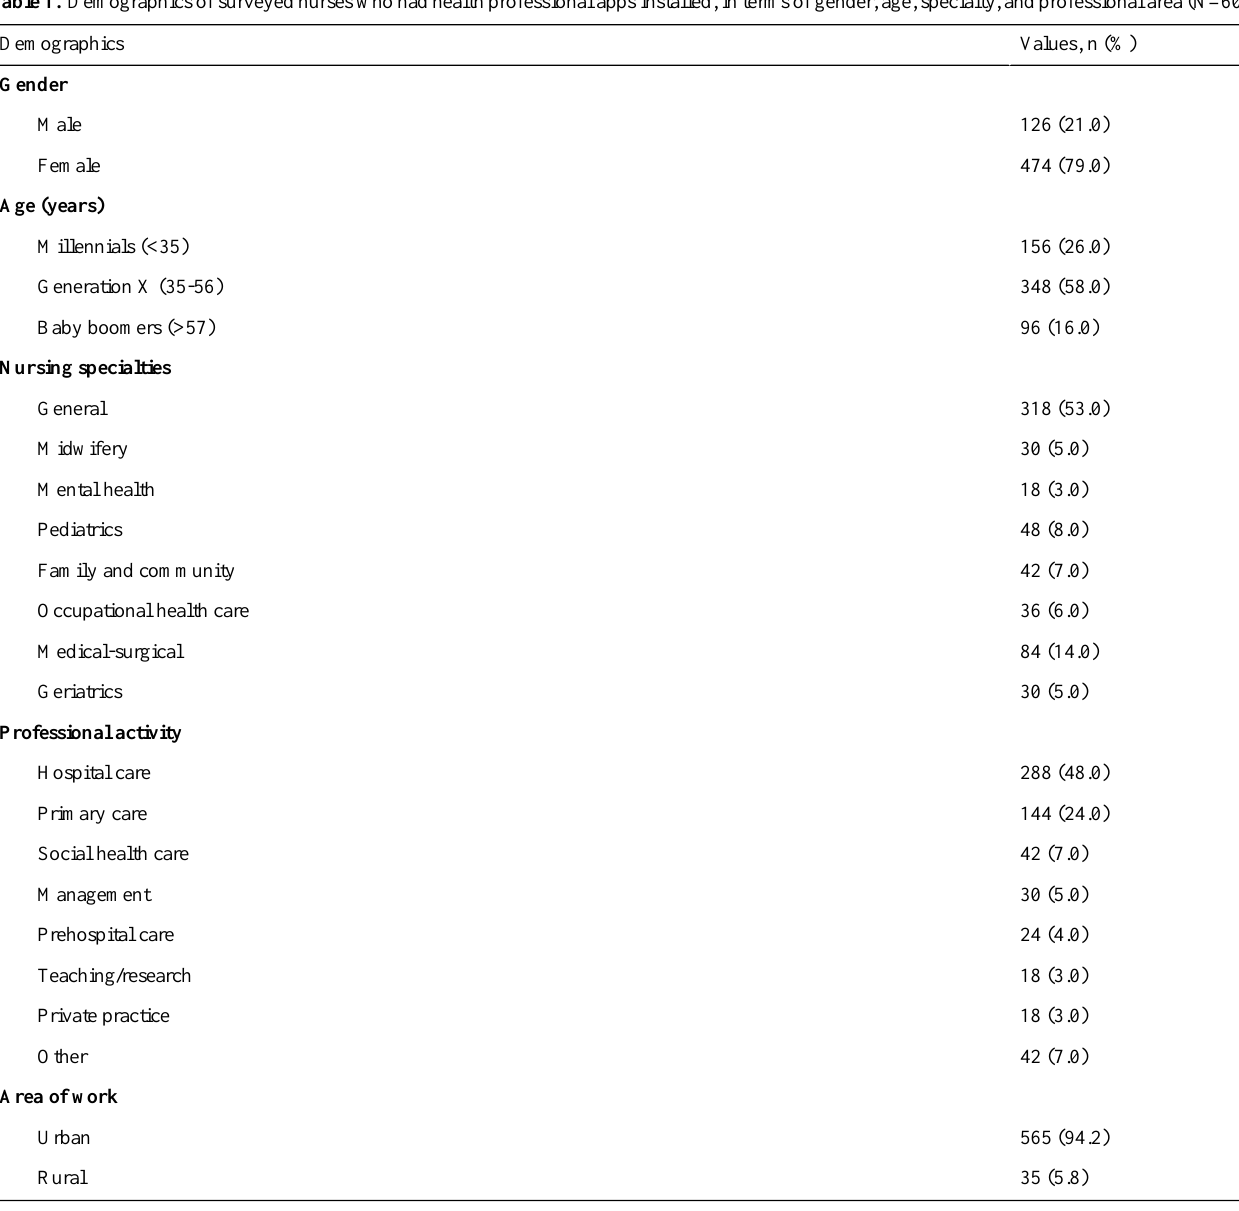
Table 1. Demographics of surveyed nurses who had health professional apps installed, in terms of gender, age, specialty, and professional area